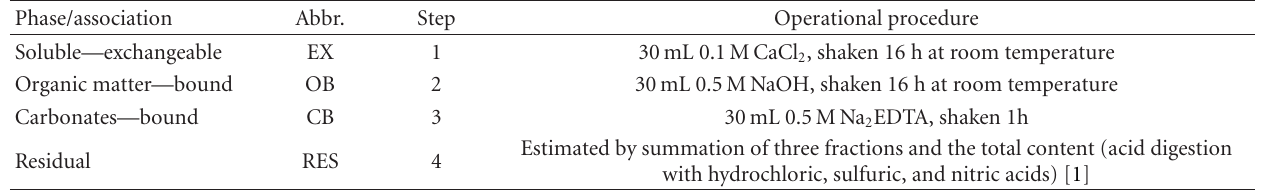
Table 4: Sequential extraction procedure of heavy metals from soil samples and operationally defined